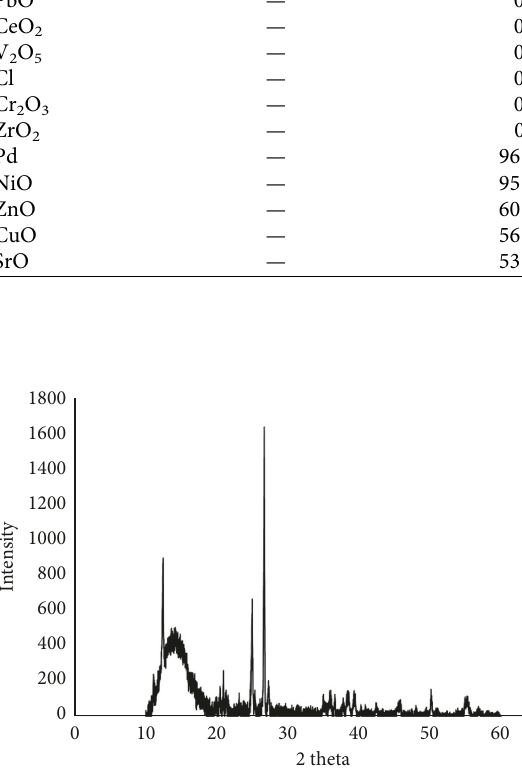
Figure 1: XRD image of Metakaolin.